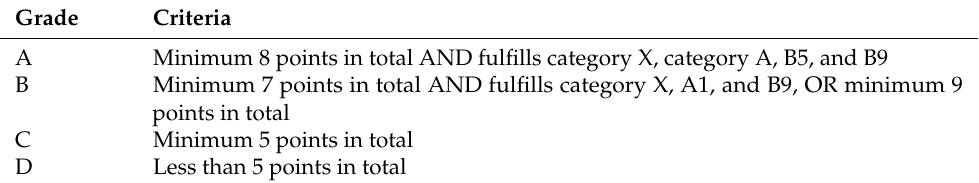
Table 3. Grading system.